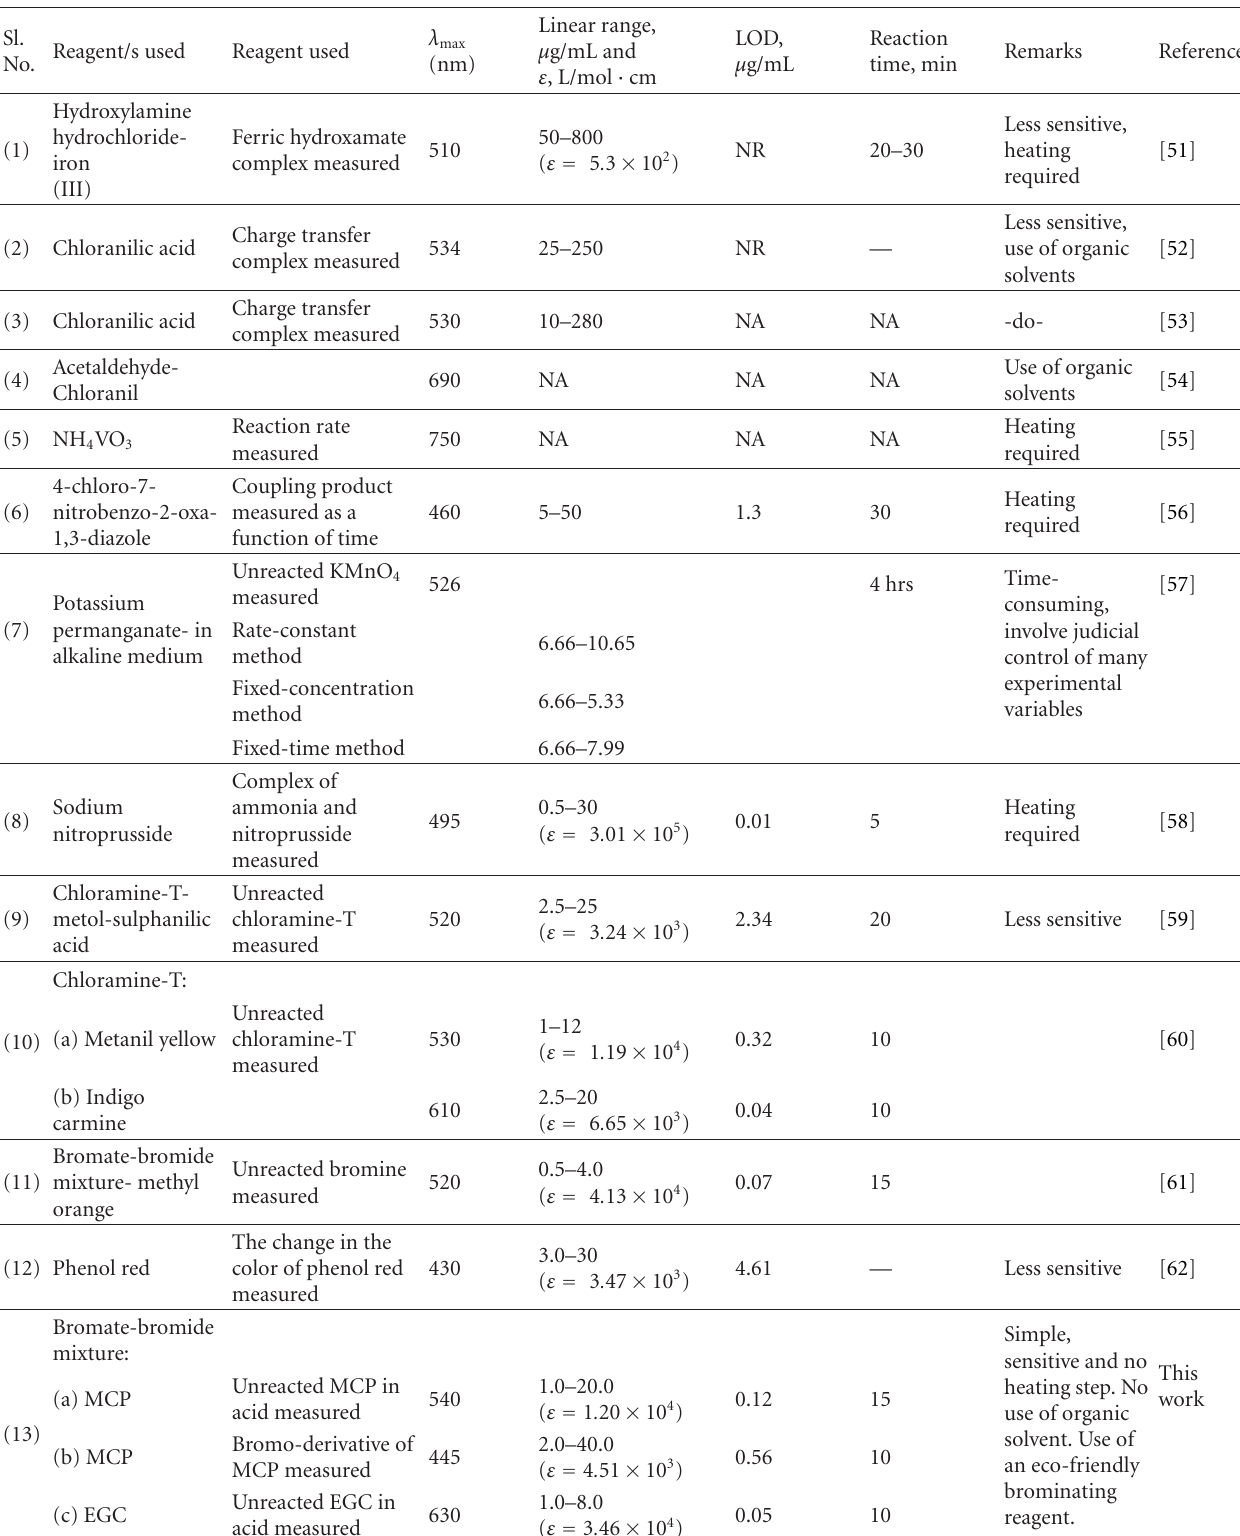
Table 1: Comparison of the proposed and the existing visible spectrophotometric